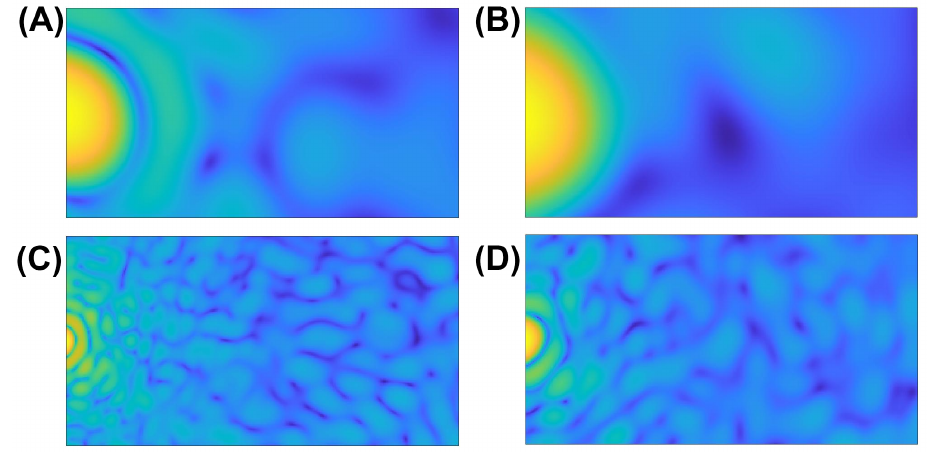
Figure 3. Segments of forward scattering TAOS data showing effect of both geometric and optical size of the aggregate. ( A ) 2 µ m nominal aggregate diameter comprised of 0.5 µ m diameter spheres illuminated at 405 nm; ( B ) 2 µ m nominal aggregate diameter comprised of 0.5 µ m diameter spheres illuminated at 660 nm; ( C ) 10 µ m nominal aggregate diameter comprised of 2.5 µ m diameter spheres illuminated at 405 nm; ( D ) 10 µ m nominal aggregate diameter comprised of 2.5 µ m diameter spheres illuminated at 660